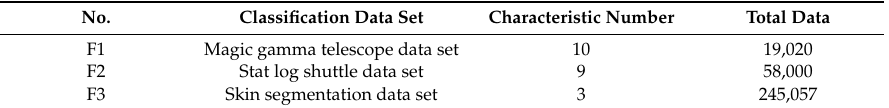
Table 1. Details of the classification data